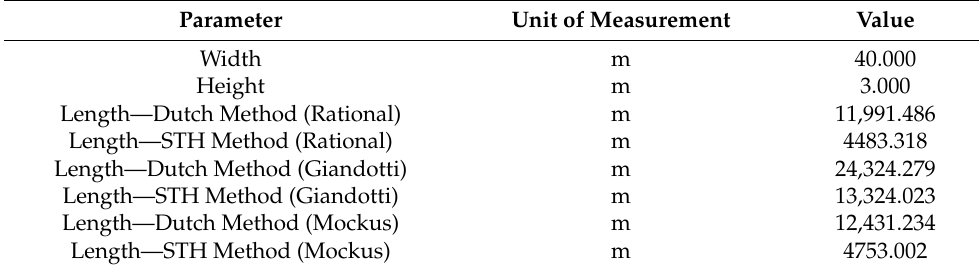
Table 8. Detention basin sizing.